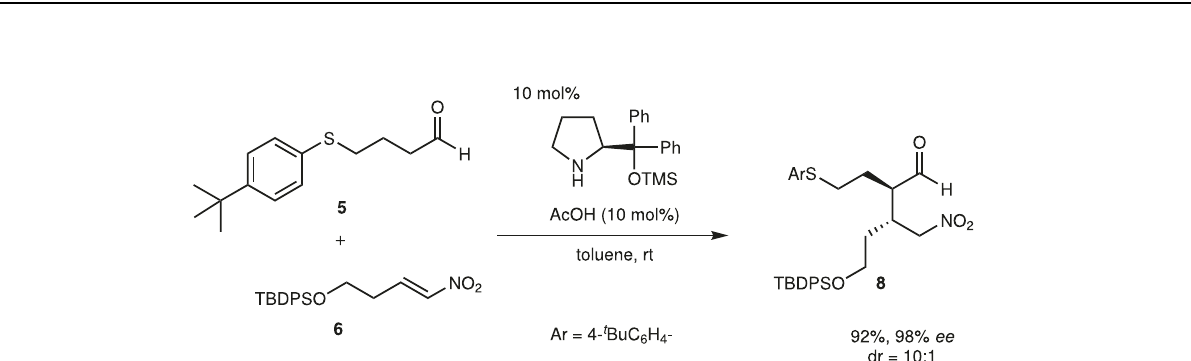
Fig. 2 | Previous work. One-pot synthesis of a piperidine skeleton via a sequential reaction of the diphenylprolinol silyl ether-mediated Michael reaction, aza-Henry reaction, and hemiaminalization reaction. Et ethyl, Ns p -nitrophenylsulfonyl, Ph phenyl, TFA tri fl uoroacetic acid, TMS trimethylsilyl.